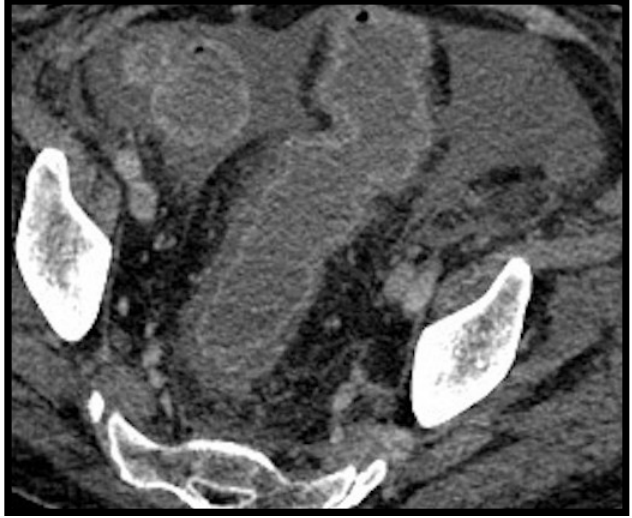
Figure 14. Colitis. Edematous thickening of the walls of the rectum-sigma with hyperdense aspects of the mucosa showing contrast enhancement after administration of contrast medium. Intra-abdominal effusion is associated.